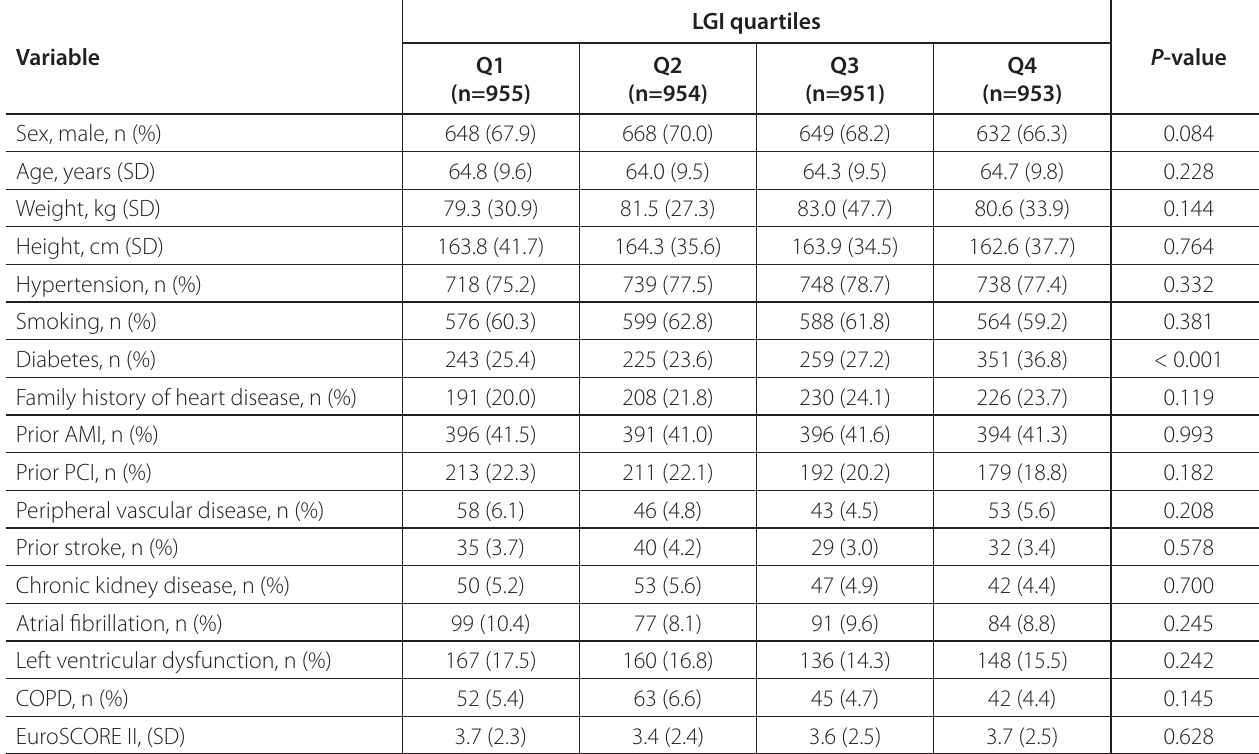
Table 1 . Basal characteristics of the population according to LGI.